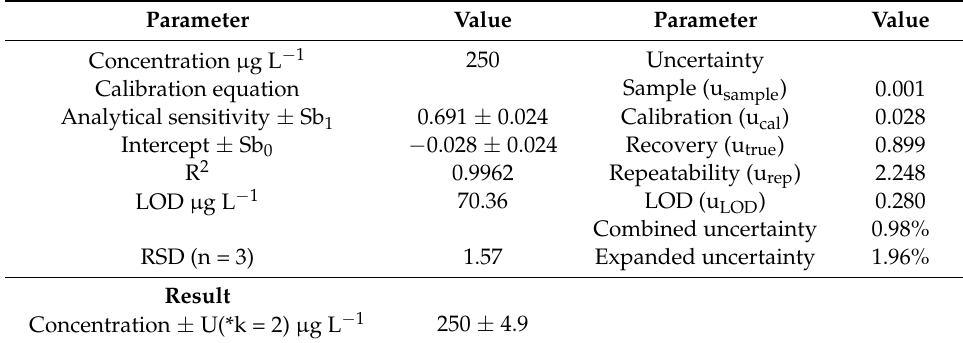
Table 1. Validation results and uncertainty estimates employing spiked milk